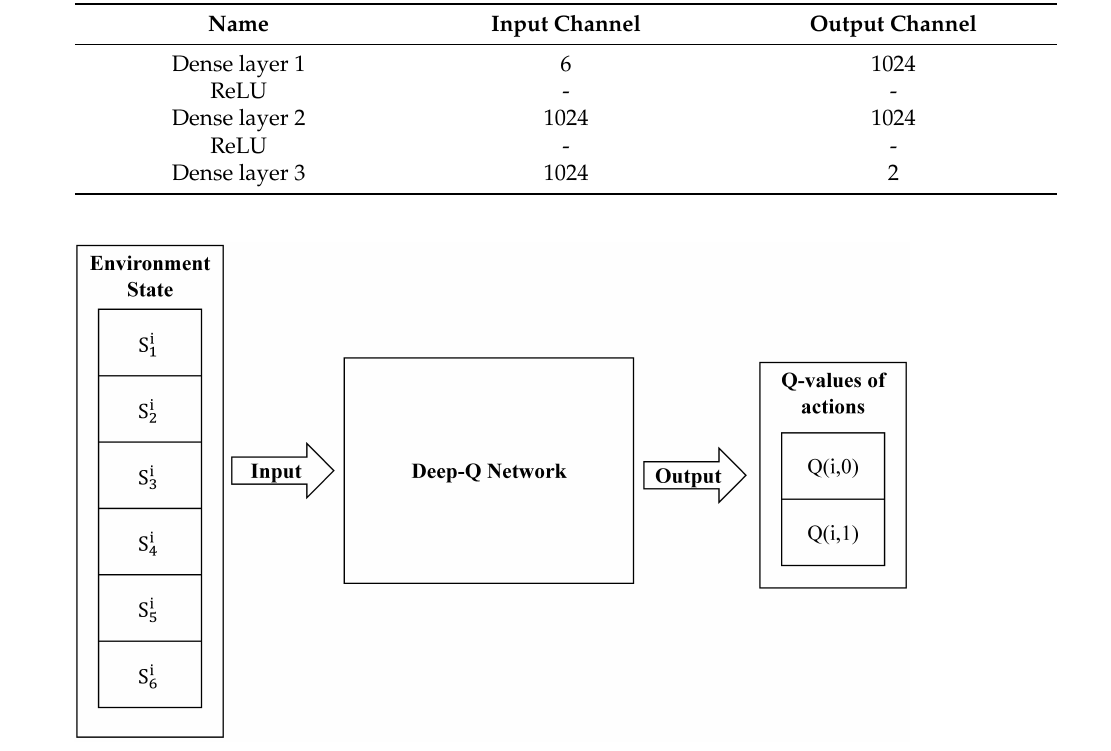
Figure 2. DQN-based search strategy.